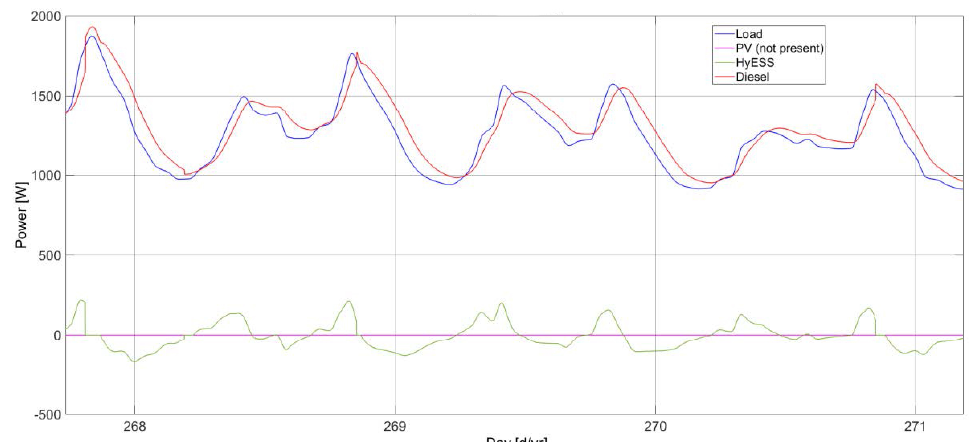
Figure 16. Example of load smoothing of the system (BESS + generators).